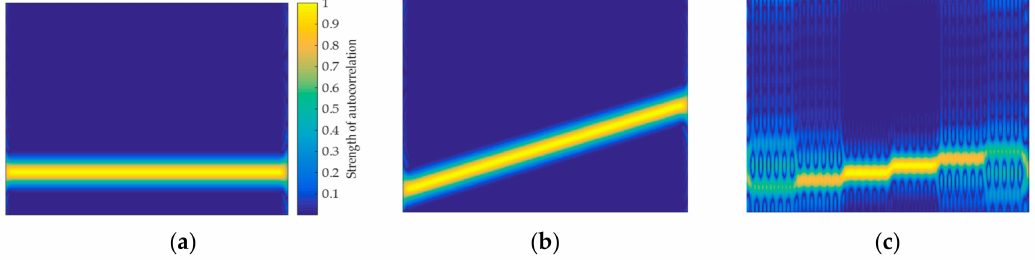
Figure 2. Time-frequency feature images of signals: ( a ) Single frequency; ( b ) linear frequency modulation (LFM); ( c )